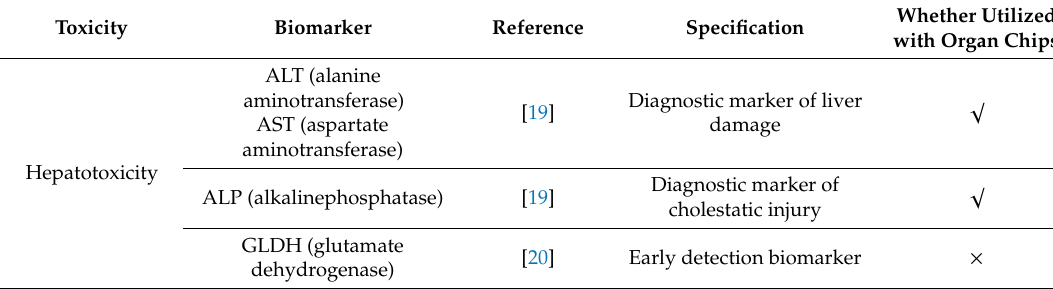
Table 1. Some common biomarkers for drug toxicity